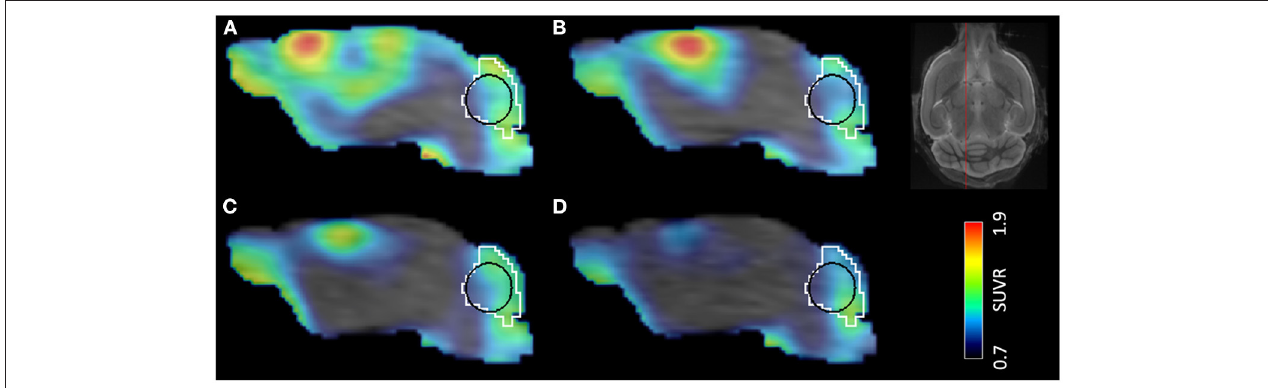
FIGURE 2 | Time development of PT in a single mouse demonstrated by [ 18 F]GE-180 PET/MR. Timepoints after the surgery: (A) 7 days, (B) 28 days, (C) 84 days, (D) 168 days. VOIs shown in the image: white—cerebellum, black—cerebellar white matter. The location of the sagittal slice on a template MR image is shown on the top right.